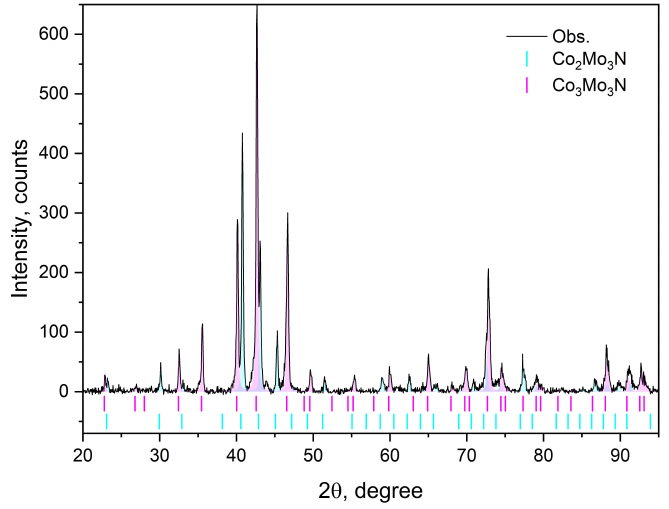
Figure 1. X-ray diffraction pattern of the COMON catalyst containing 0.2 wt.% of potassium acquired after ammonolysis, with the indicated Rietveld